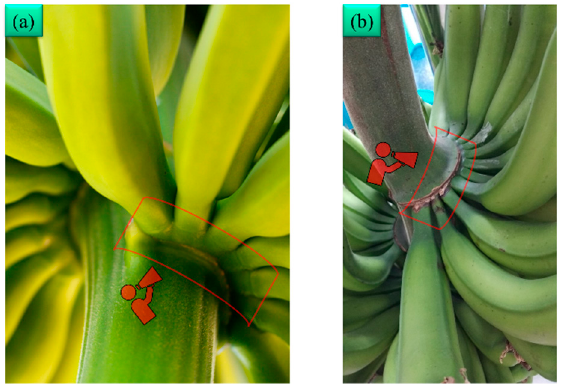
Figure 15. Irregular ring domains at the fruit node. ( a ) The appearance of the fruit node when looking up, ( b ) The appearance of the fruit node in bird’s ‐ eye view.